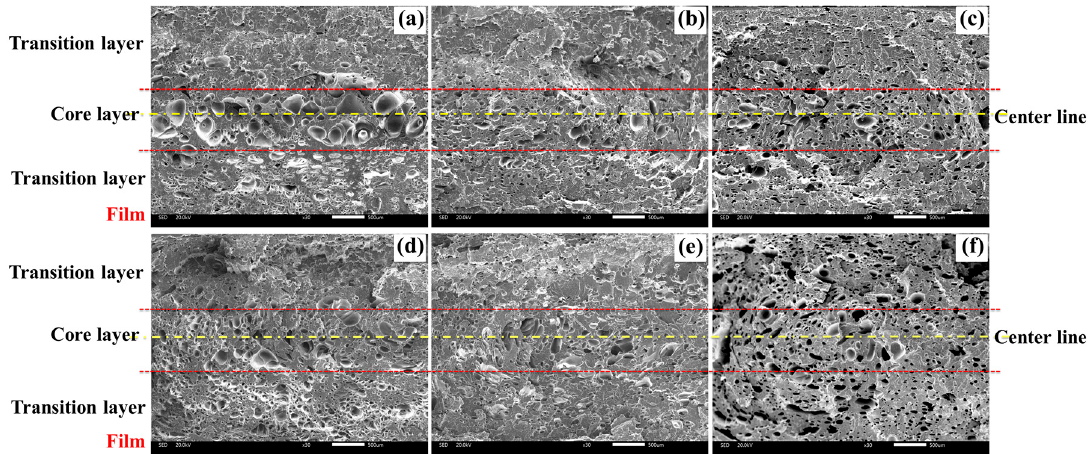
Figure 10. Cellular structure of foamed composites in vertical sections with different nano-CaCO 3 content: ( a ) 0 wt %; ( b ) 2 wt %; ( c ) 4 wt %; ( d ) 6 wt %; ( e ) 8 wt %; ( f ) 10 wt %.